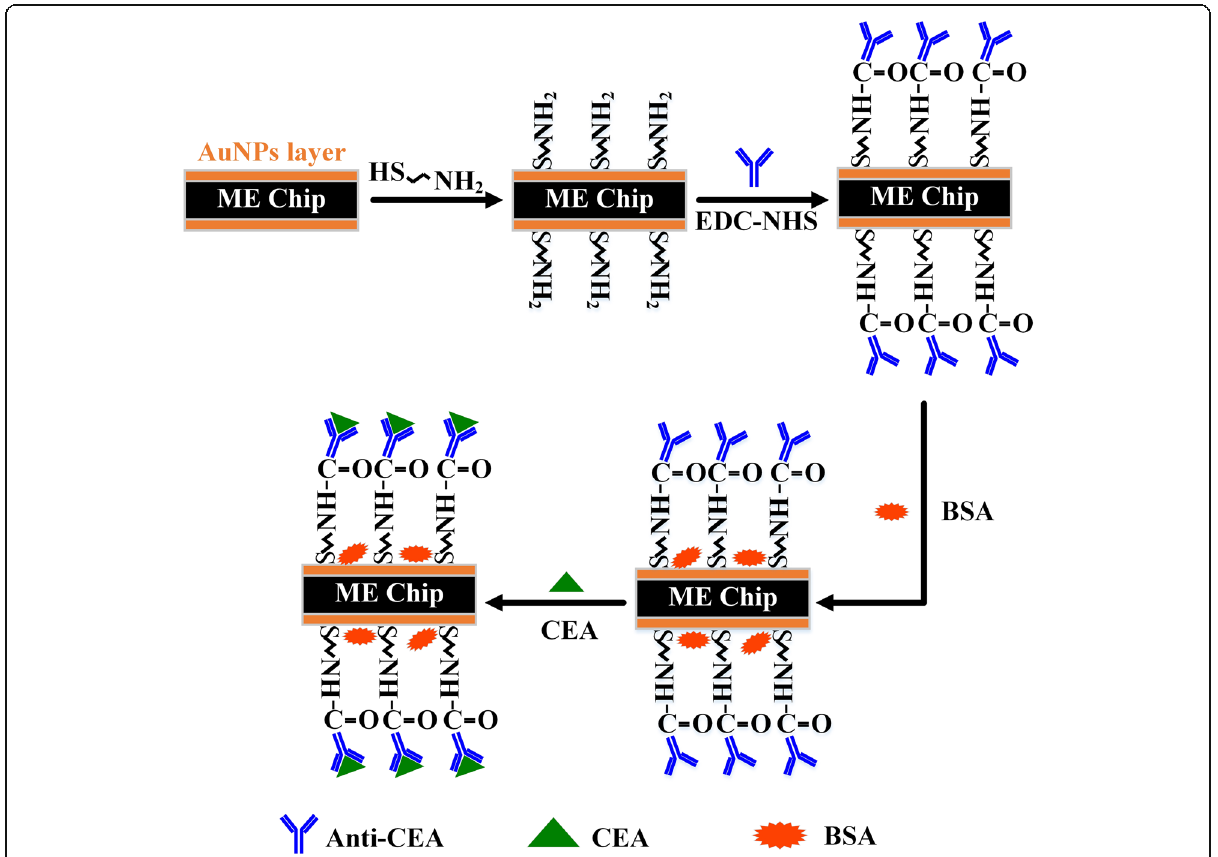
Fig. 2 Scheme of the constructed Nano-ME biosensor